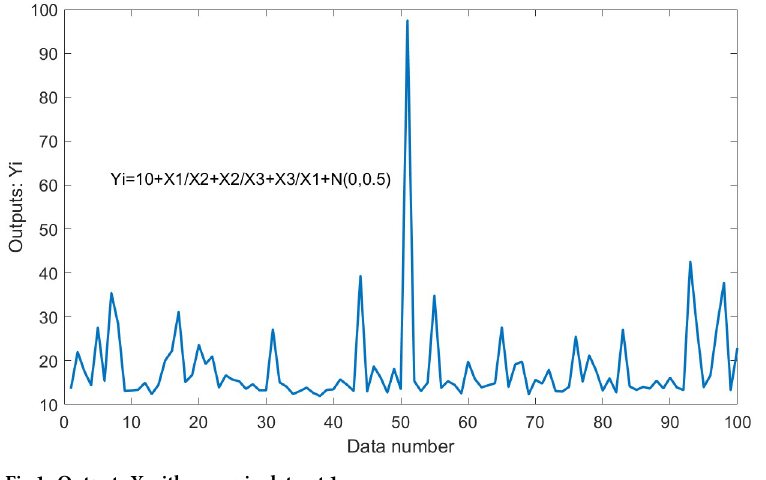
Fig 1. Outputs Y with errors in dataset 1.